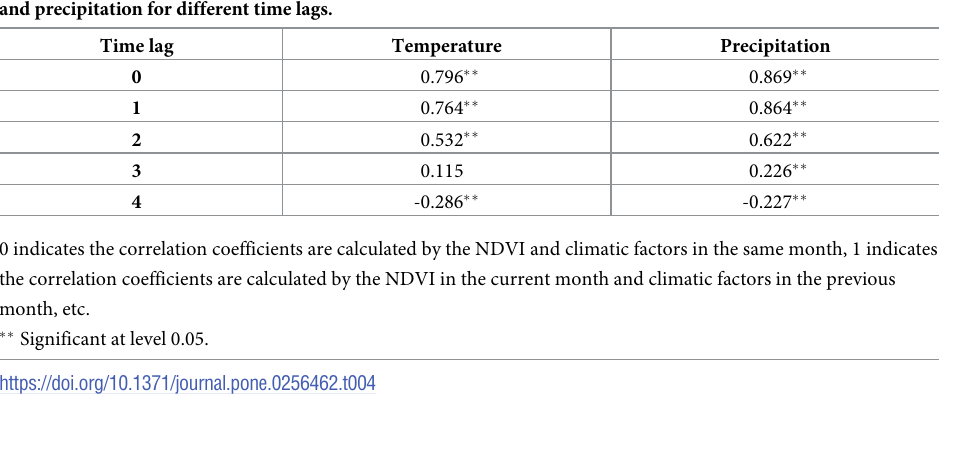
Table 4. The Pearson correlation coefficient for the relationship between the monthly NDVI and temperature and precipitation for different time lags. Time lag Temperature Precipitation 0